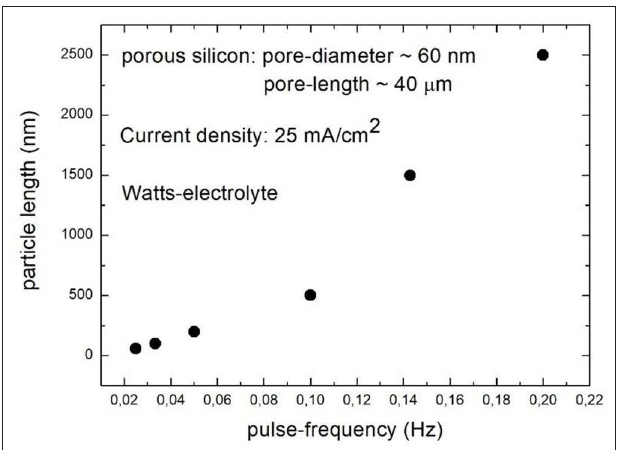
FIGURE 12 | Pulse frequency vs. elongation of Ni deposits. With increasing pulse frequency the length of the Ni structures is increased. Granitzer et al. [83], ECS with permission.